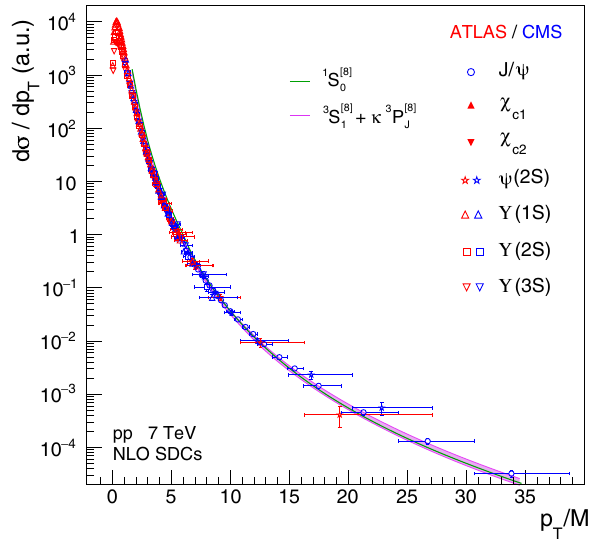
Fig. 4 The J /ψ , ψ( 2S ) , and ϒ (1S) polarization parameters as a func- tion of p T / M , measured at mid-rapidity by the CMS experiment, com- (green) and 3 S [ 8 ] (red) pared to the NRQCD calculations for the 1 S [ 8 ] 0 1 + κ 3 P [ 8 ] octets, as well as to the 3 S [ 8 ] combination with κ = 1 . 8–1.85 J 1 (magenta